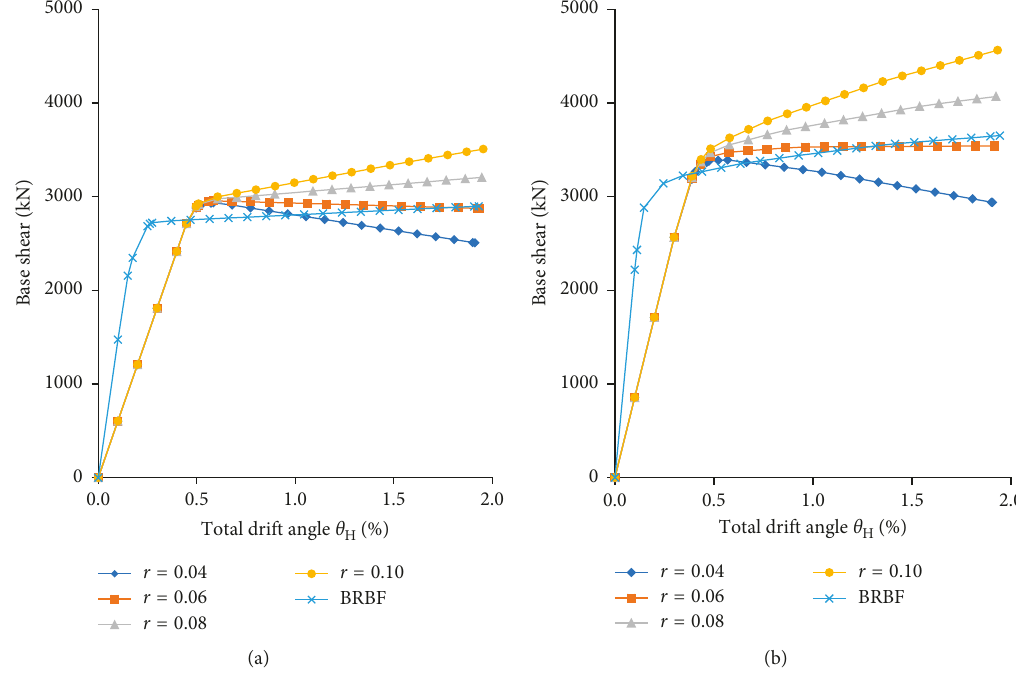
Figure 12: The effects of r on the base shear response of 9-story SC-TOBFs: (a) LD-1 and (b)